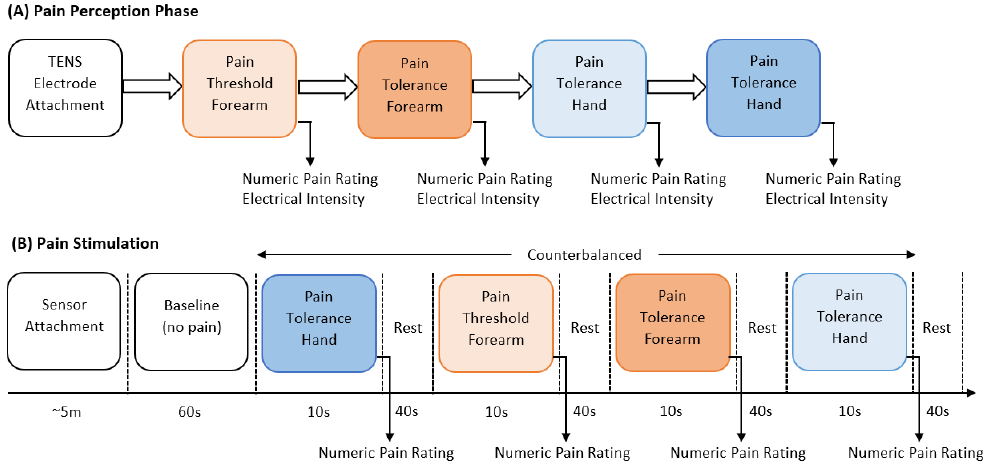
Figure 1. Schematic representation of stimulation and perception of pain.